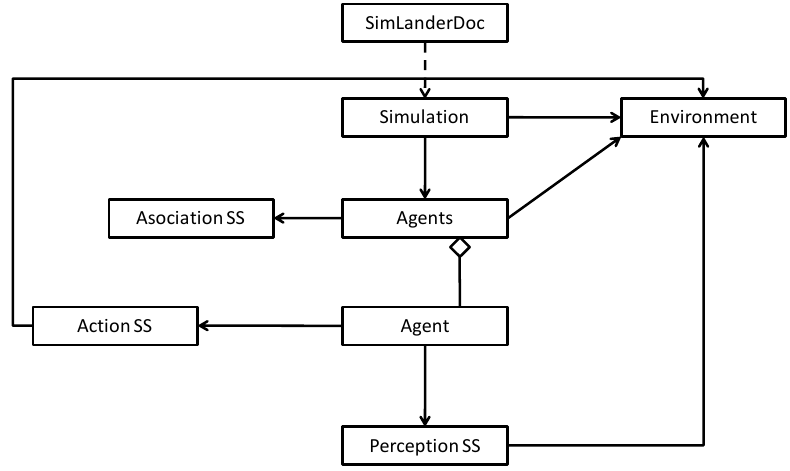
Figure 9. Simulation package class diagram.